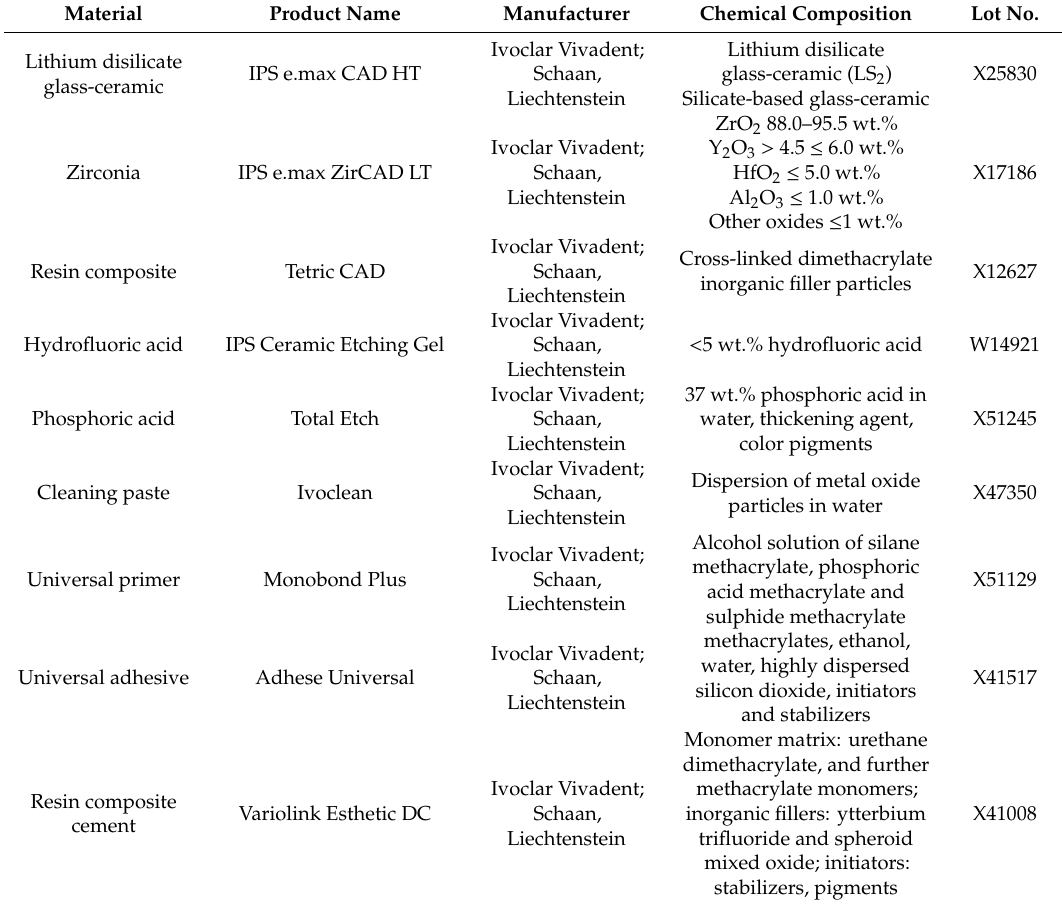
Table 1. List of the materials used according the product name, manufacturer, chemical composition and Lot No.